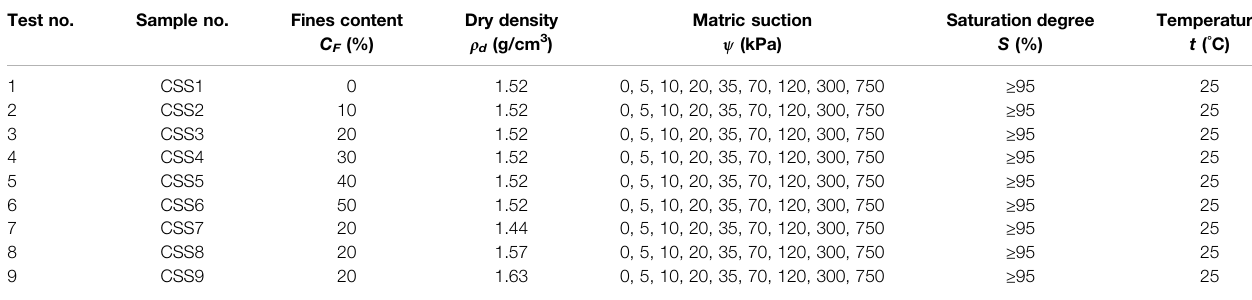
TABLE 2 | Experimental design scheme of water desorption tests. Test no. Sample no.